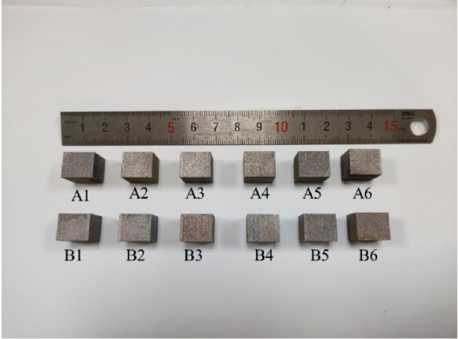
Figure 3. Specimens fabricated by SLM with different processing parameters.